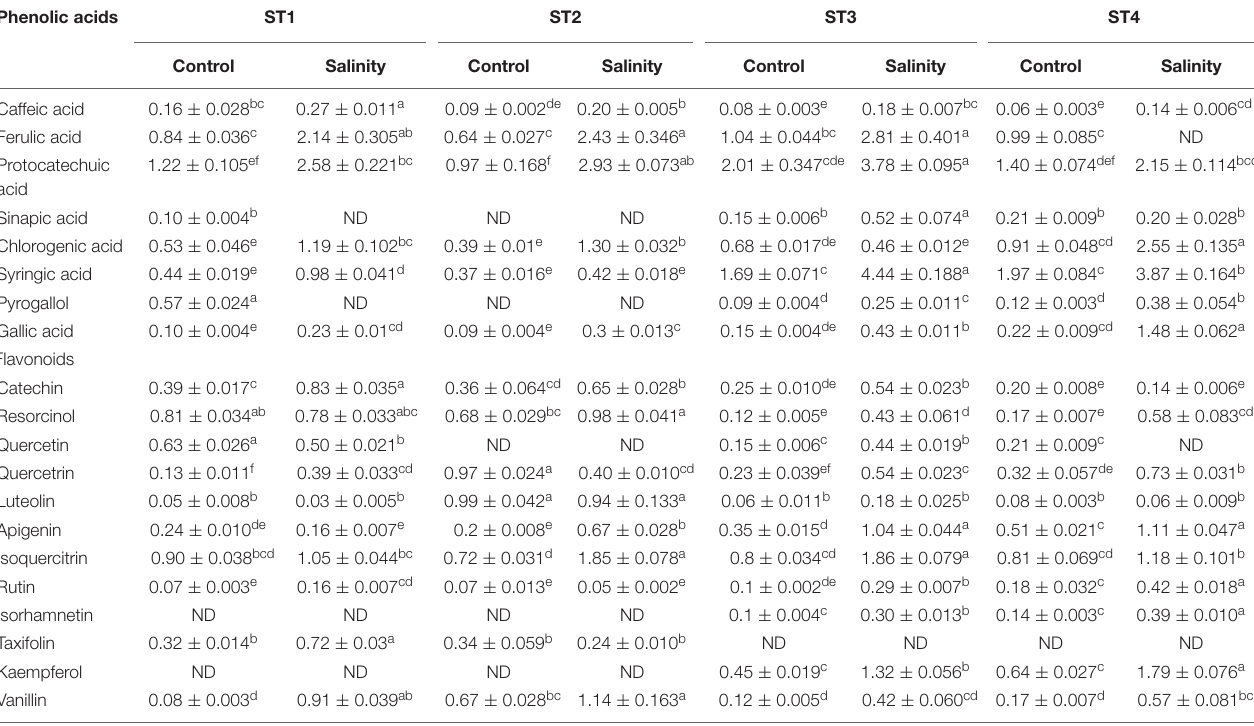
TABLE 1 | Individual phenolic acids and flavonoids produced by the four salt-tolerant isolates (ST1, ST2, ST3, and ST4) under control or salinity stress conditions. Phenolic acids